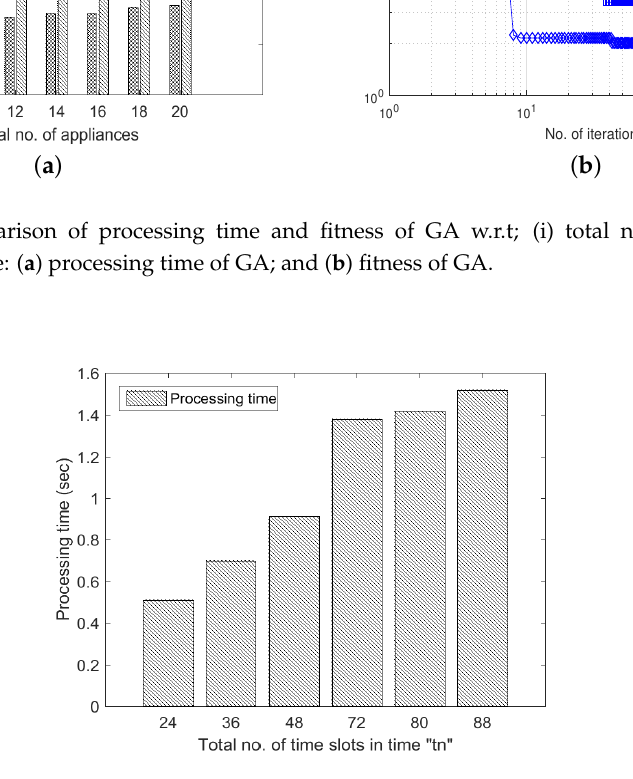
Figure 6. Analysis of processing time of GA w.r.t total number of time slots (for single appliance